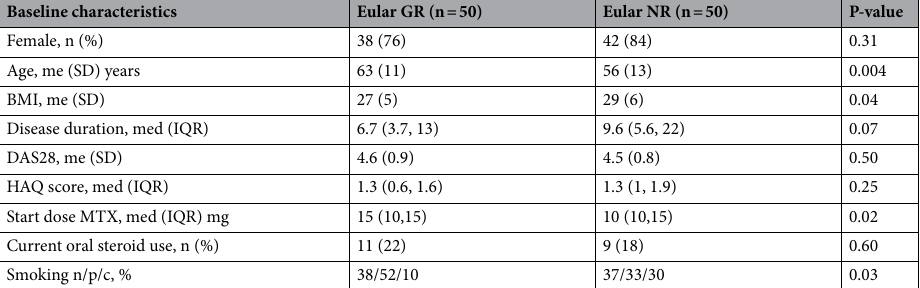
were used to assess data complexity. The distance matrix required for hierarchical clustering was produced using the complete linkage method (furthest neighbour).The Pearson method was used to compute the correlation matrix required to produce the heat map. Gaussian mixture models, fitted by the expectation–maximization algorithm, were assessed using the Bayesian Information Criterion (BIC). Regression analysis. Linear mixed effect models were developed to detect correlation between individual lipid levels and response to MTX, incorporating the pre-treatment and 4-week sample. Fixed effects included clinical and demographic parameters (i.e. patient sex, age-at-inclusion, MTX start dose, BMI and smoking history) and a patient identifier was included as a random effect. To determine if lipid effects on future treatment response were time-point dependent, an interaction term was specified between time-point and EULAR response. The false discovery rate (FDR) was used to control for Type 1 error at the 5% threshold. Prediction. Machine learning models were built to classify MTX response at 6 months using serum lipid pro- files at pre-treatment, following 4 weeks on drug and by taking the difference in serum lipid levels between the 4-week and pre-treatment sample. Models including metabolite levels were compared to models including the following clinical parameters: MTX start dose, steroid use at inclusion, BMI, number of swollen joints, number of tender joints, CRP levels, patients’ assessment of their overall wellbeing, sex, age-at-inclusion, age-at-onset, disease duration, HAQ score and pre-treatment smoking habits. For each contrast, we employed three state-of- the-art machine learning methods: random forest, a kernel-based approach (i.e. radial kernel support vector machine) and regularized logistic regression, a strategy that uses a loss function designed to drop the features that are not predictive. Each model was run under a fivefold nested cross-validation scheme (where hyper- parameters were computed in each of the strata using an inner fivefold cross validation loop, with the default tuneGrid parameters in the caret library 18 , and a tuneLength of 100) to give accurate estimates of predicted performance. Model performance is reported using receiver operating characteristic (ROC) curves; the average ROC area under the curve (AUC) is reported along with the standard errors of the mean (± SE). All ROC AUCs